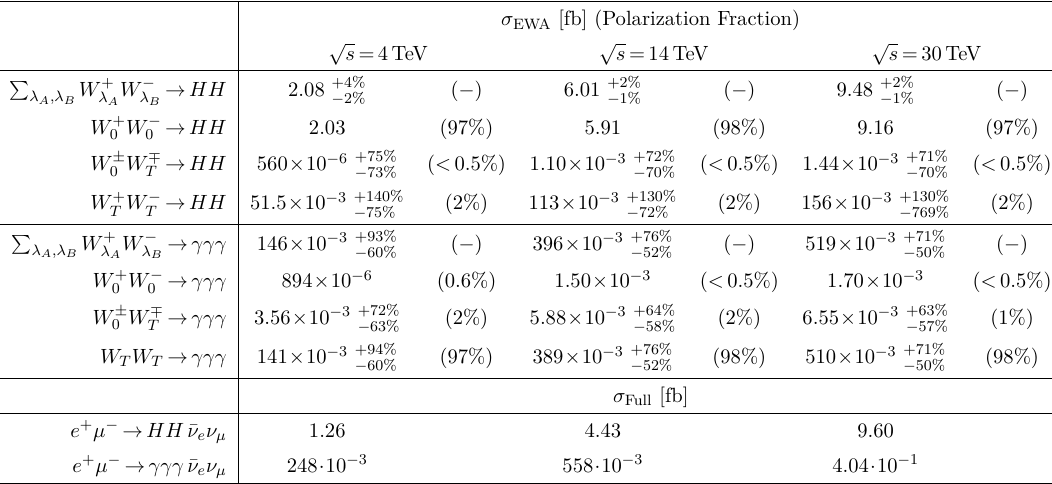
W − → λ A λ B √ s = 4 , 14, W − → γγγ , assuming the phase space cuts λ A λ B